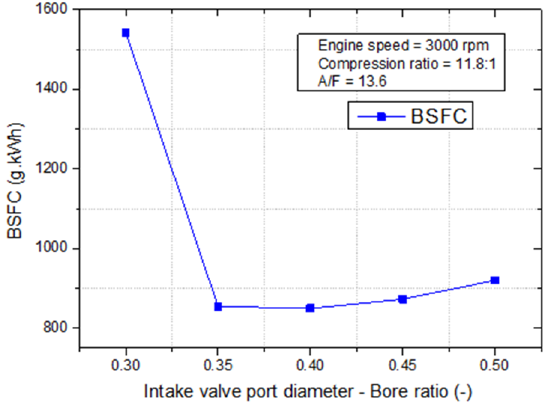
Figure 11. BSFC versus IPD/B.